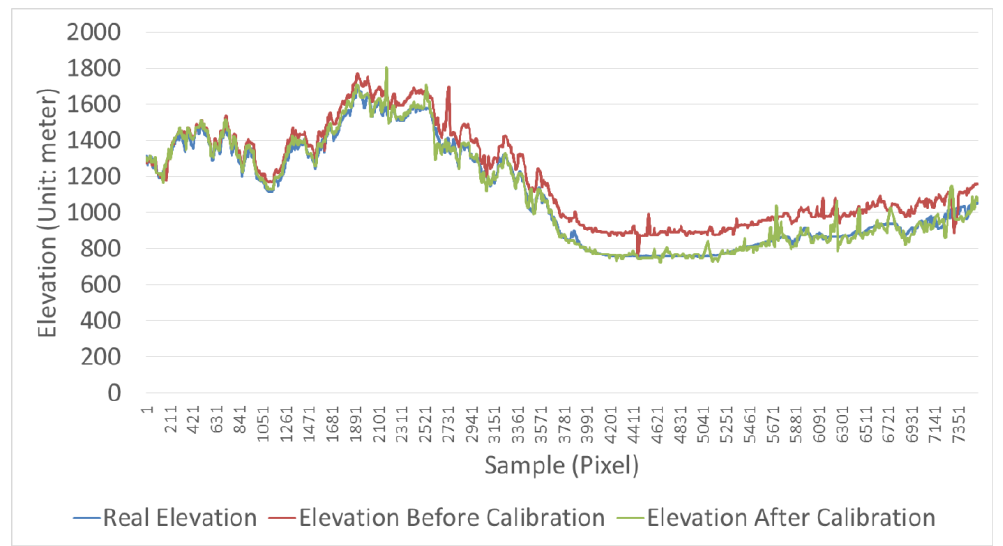
Figure 9. Elevation profile plot.